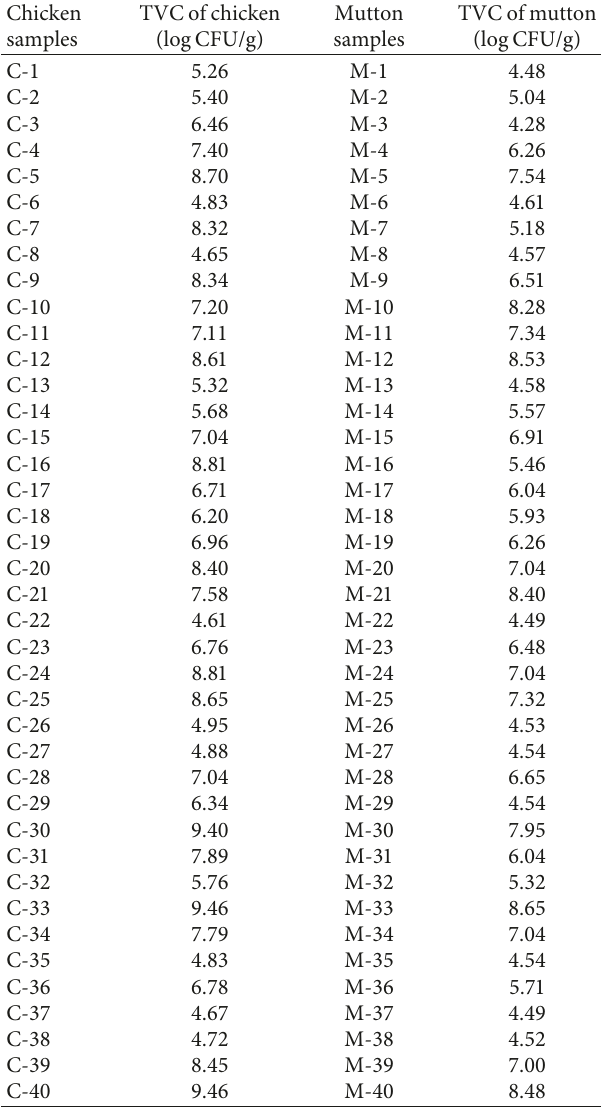
Table 2: Total viable count (TVC) in chicken and mutton